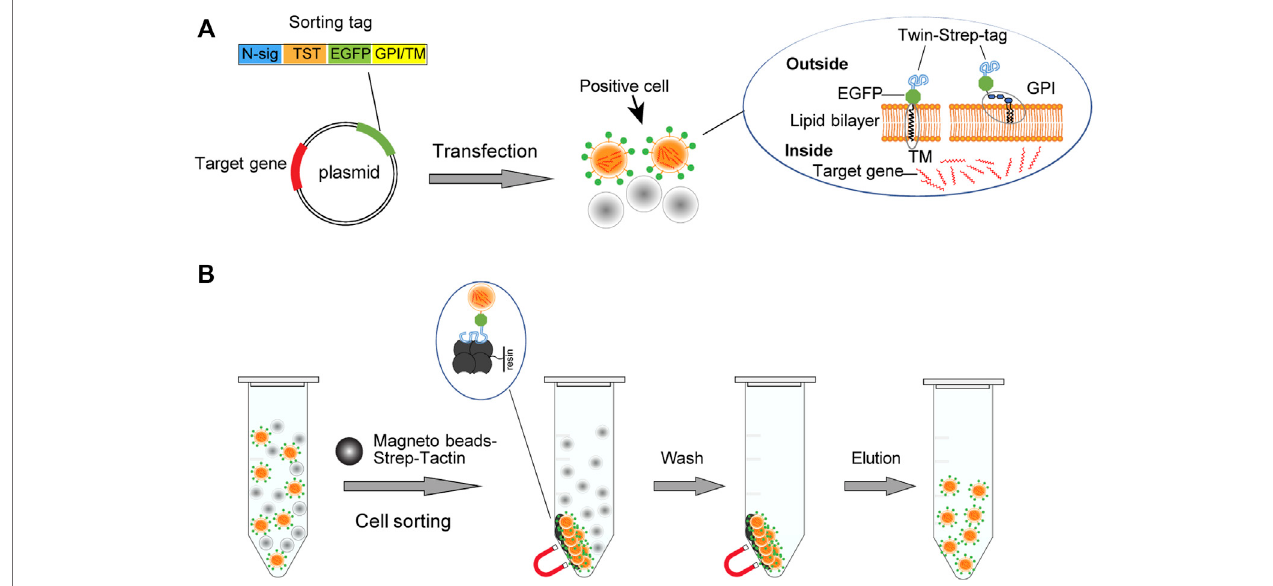
FIGURE 1 | Schematic illustration of the cell sorting strategy. (A) The vector expresses the TST-EGFP sorting tag that targets the cell membrane through a glycosylated phosphatidylinositol (GPI) module or a transmembrane domain (TM). (B) The high af fi nity between TST and Strep-Tactin allows the gene transfection- positive cells displaying the sorting tag to be bound and enriched with the magnetic Strep-Tactin beads. Transfection-positive cells are displayed in orange. The separation of the bead/cell complex can be performed by staying on a magnetic stand or by free settling.